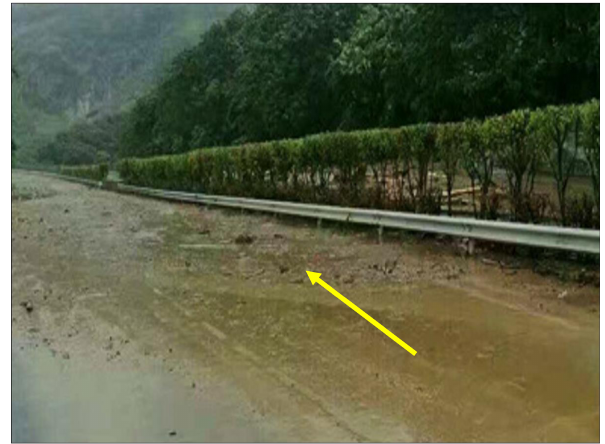
Figure 1. Soil erosion produced by rainwash on a slope after rain-